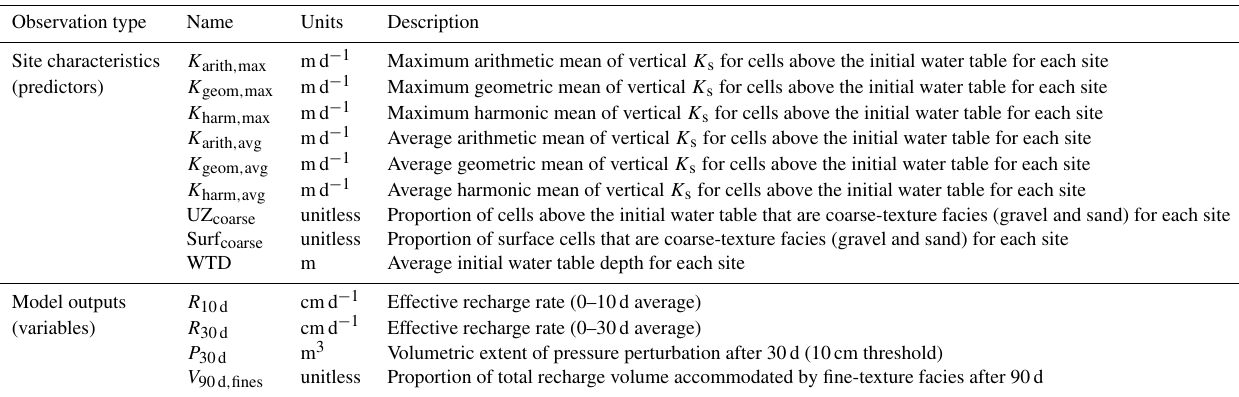
Table 3. Descriptions of site characteristics (variables) and model outputs